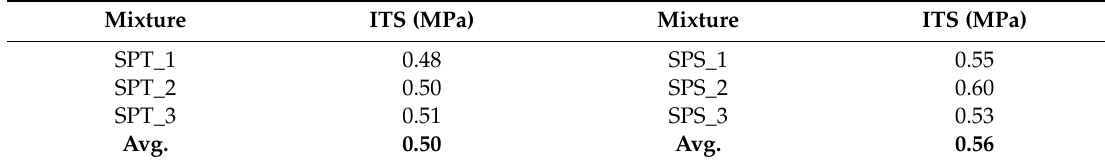
Table 4. Indirect Tensile Strength (ITS) test